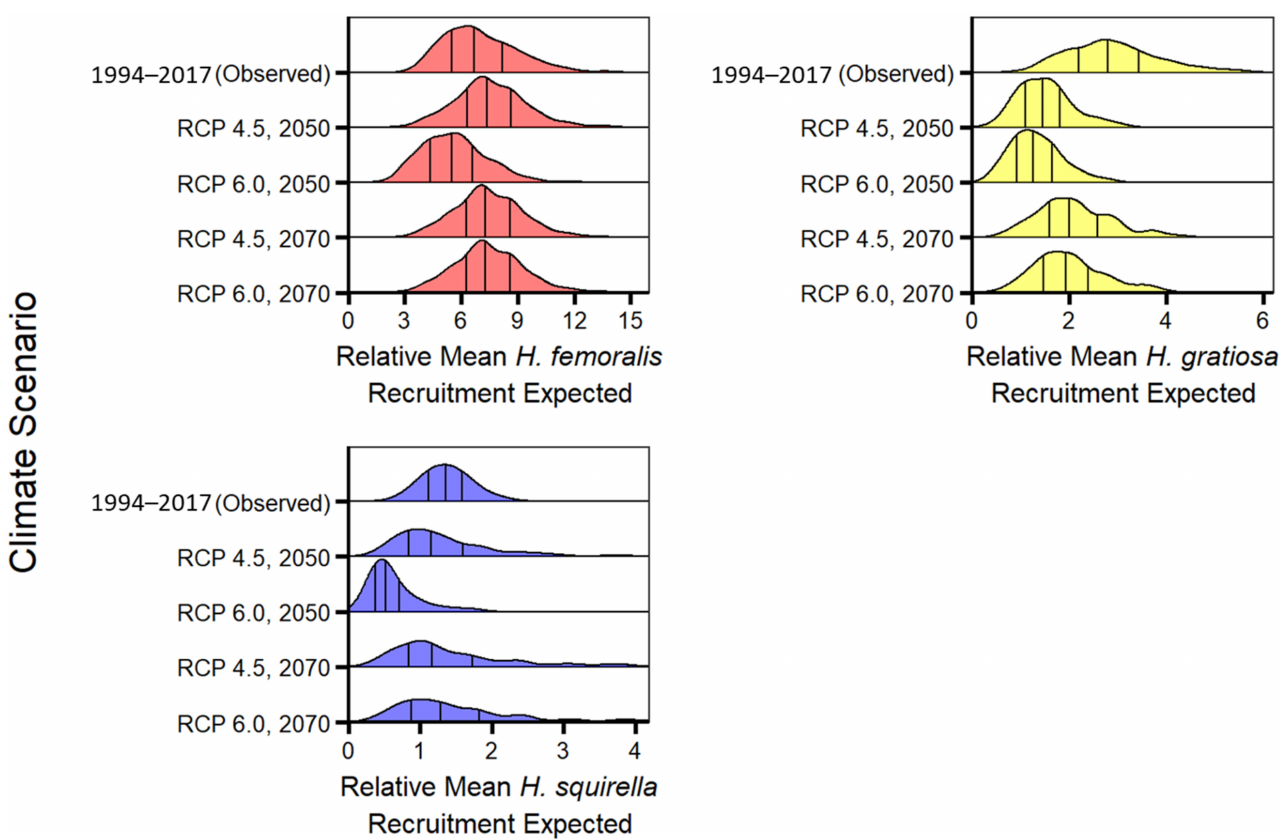
Figure 8. Bootstrapped simulations of mean recruitment using observed data (1994–2017), and prediction distributions for mean relative expected recruitment for three hylid species in 2050 and 2070 under RCP 4.5 and RCP 6.0 emissions scenarios [39], Ocala National Forest, Marion County, Florida. Vertical black bars represent 25th, 50th, and 75th percentiles of each